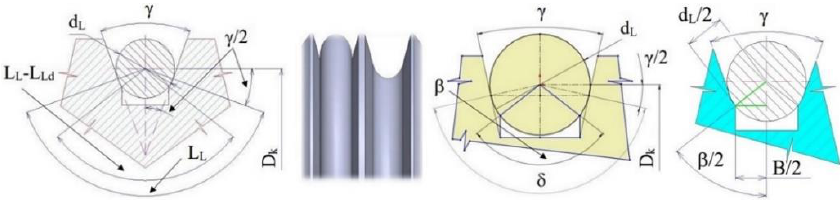
Figure 1. Cable of circular cross-section running through a semi-circular groove with a notch.